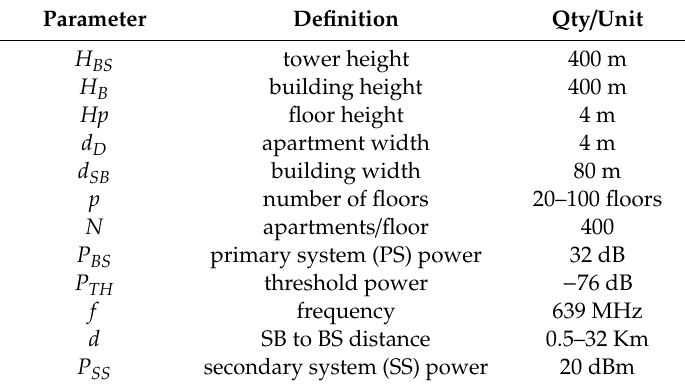
Table 2. Simulation